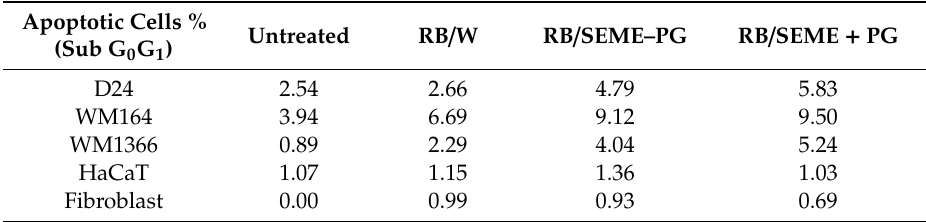
Table 4. Percentages of apoptotic cell populations of cancerous and noncancerous cell lines after 24-h treatment with RB loading formulations. Results were derived from cell cycle histograms shown in Supplementary Materials Figure